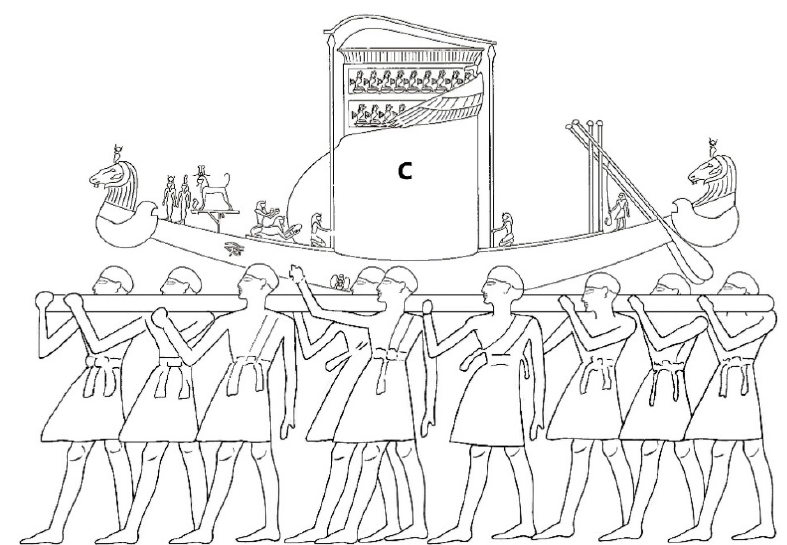
Figure 3. Depiction of a sacred bark carried in a religious festival from Karnak, dated to the reign of Queen Hatshepsut, 14th century BCE (Lacau and Chevrier 1977). A large portable shrine is located on top of a boat, with its door partly covered by a white curtain (marked C). Part of the curtain flutters to the left.